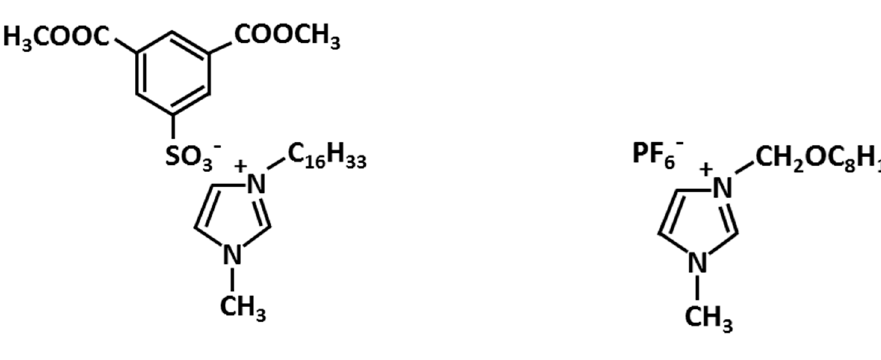
Figure 1. The chemical structures of the synthetized ILs.